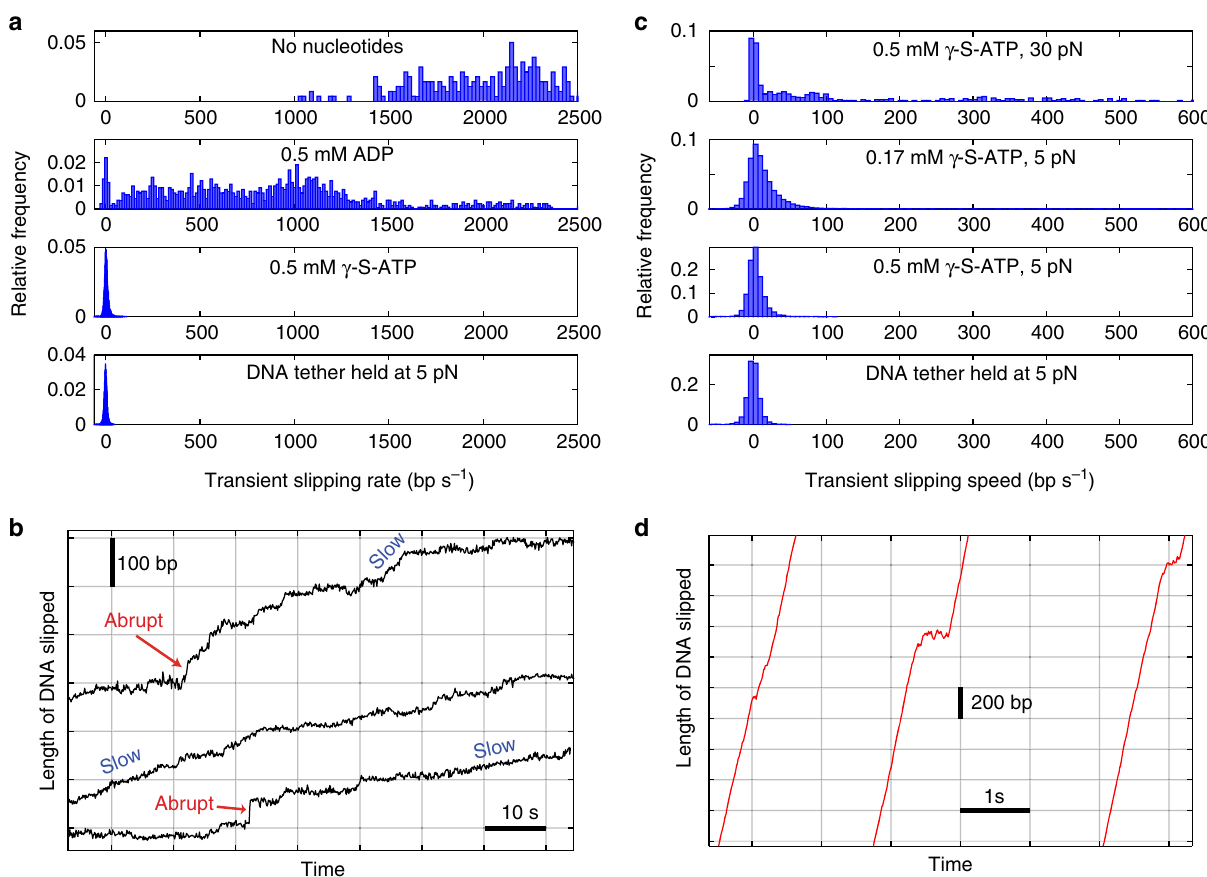
Fig. 3 DNA slipping velocities and transient slipping events. a Distributions of slipping velocities measured in 1 s time intervals in the four different conditions indicated in the plot legends. “ DNA tether held at 5 pN ” indicates results from control experiments with fi xed-length tethered DNA molecules (with no capsid motor complexes) to characterize transient non-zero velocities measured due to Brownian fl uctuations and instrument noise. b Examples of different velocities of slipping (rare “ abrupt ” slips and more common “ slow ” slips) measured with 0.5 mM γ -S-ATP. Each plotted line is a single event, arbitrarily positioned on the graph, with length and time scales indicated by the scale bars. c Distributions of slipping velocities measured in 1 s time intervals for the four different conditions indicated in the plot legends. d Examples of brief decelerations during slipping which are observed infrequently in absence of nucleotides. Each plotted line is a single event, arbitrarily positioned on the graph, with length and time scales indicated by the scale γ -S-ATP-bound exert much stronger friction on the DNA than apo subunits.